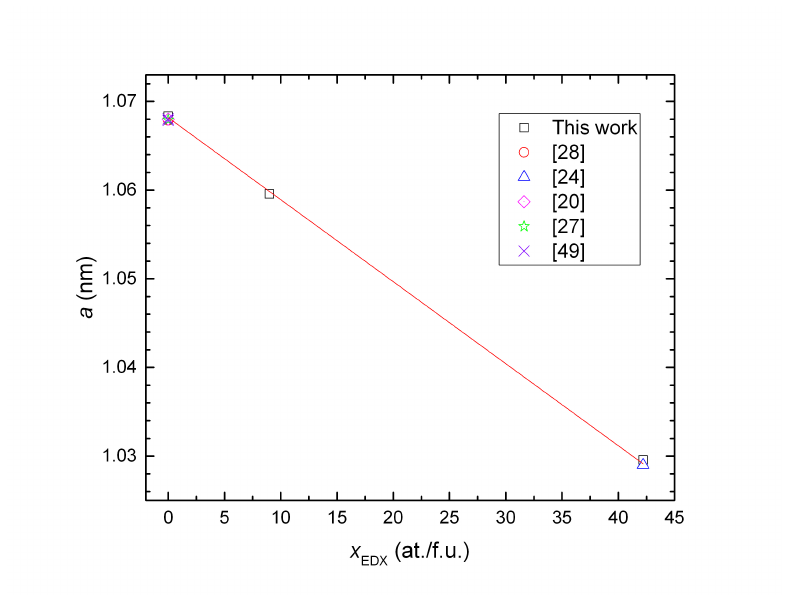
Figure 3. Lattice parameter a vs. the Si content in the clathrate phase x EDX . The lattice parameters of the ternary clathrates of similar compositions from the literature are included for